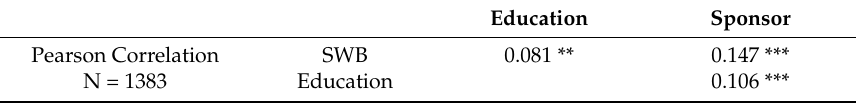
Table 6. Correlations and hierarchical regression analysis for parental SWB.